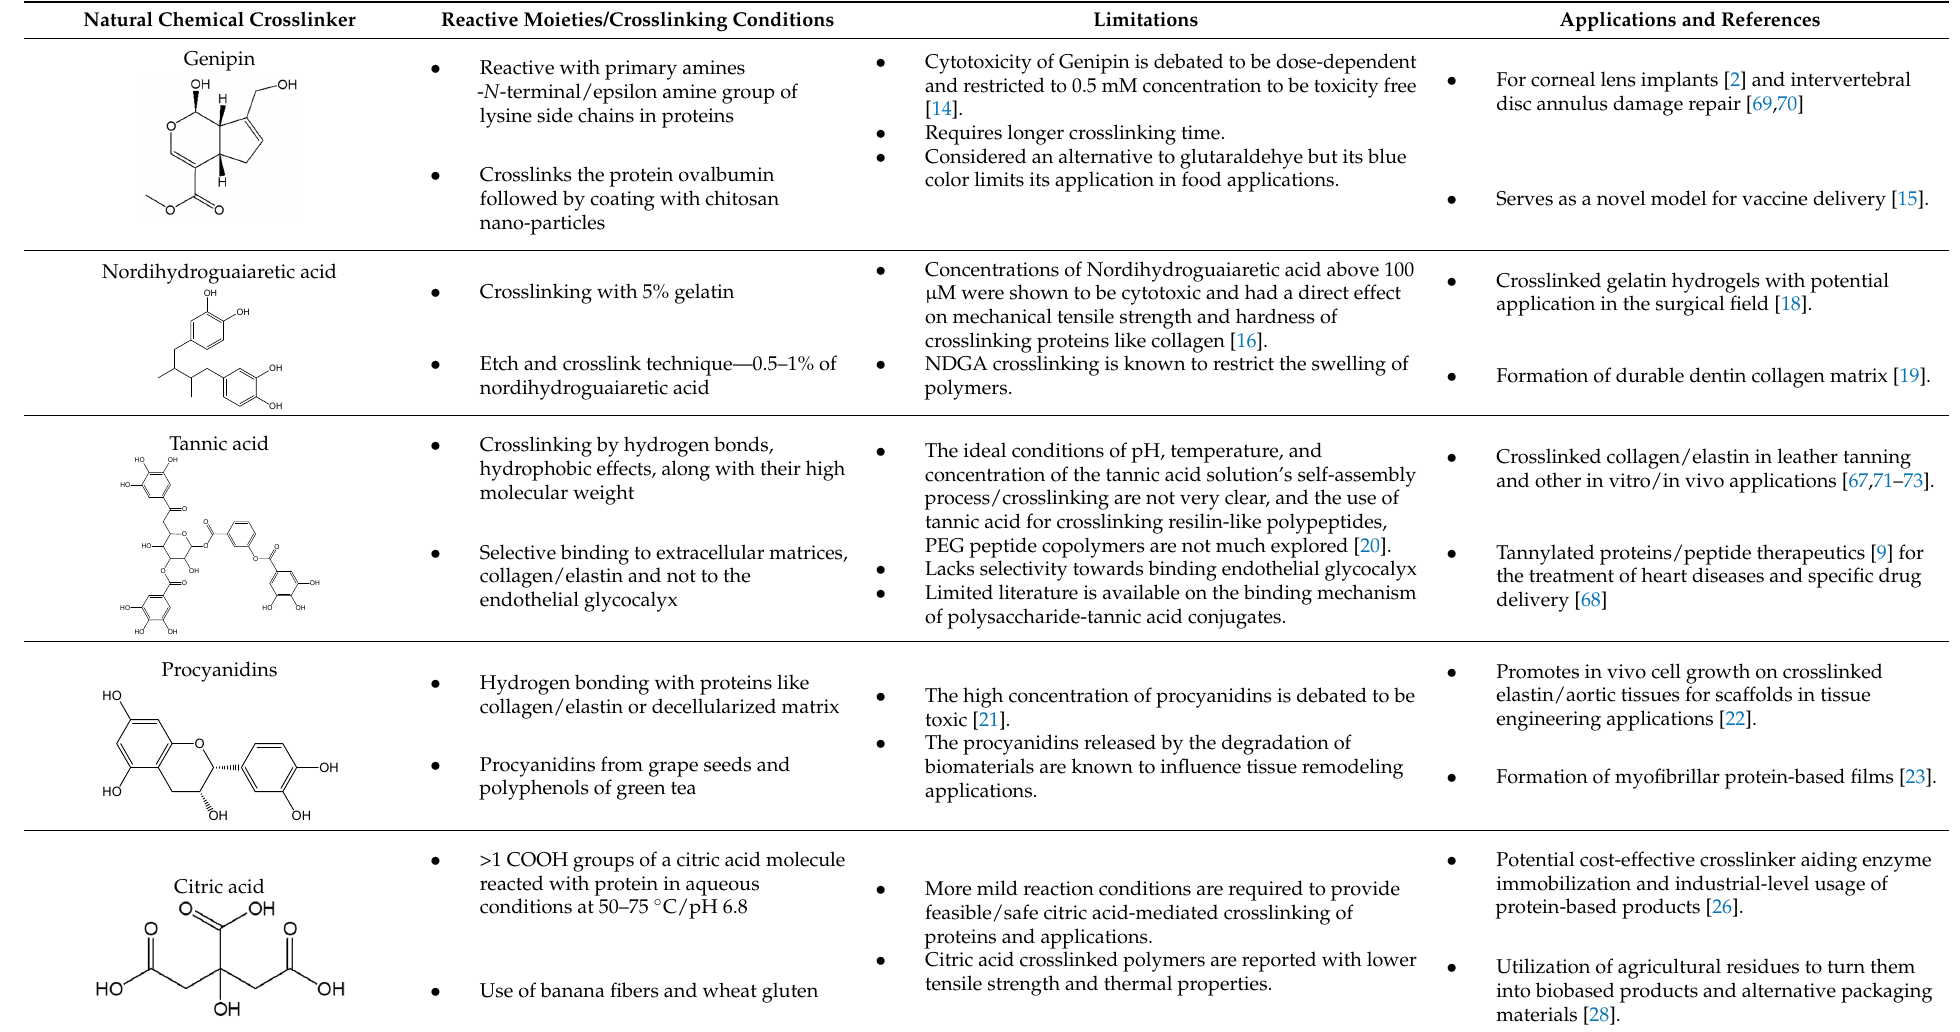
Table 1. Summary of protein crosslinking by using natural chemical crosslinkers.